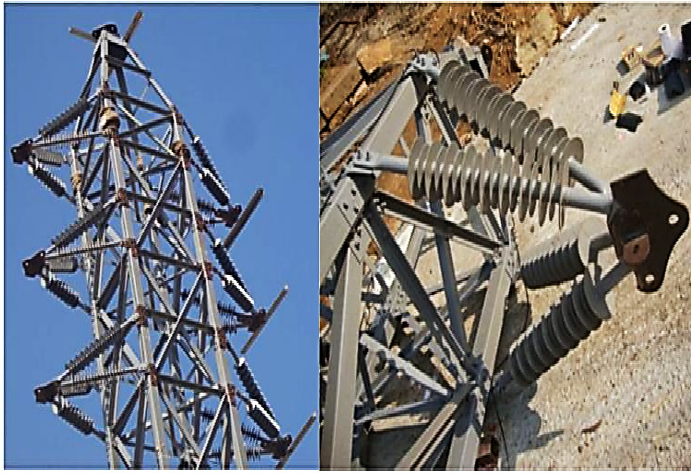
Figure 17. Composite cross ‐ arm insulators (four pultruded structure components) [40].